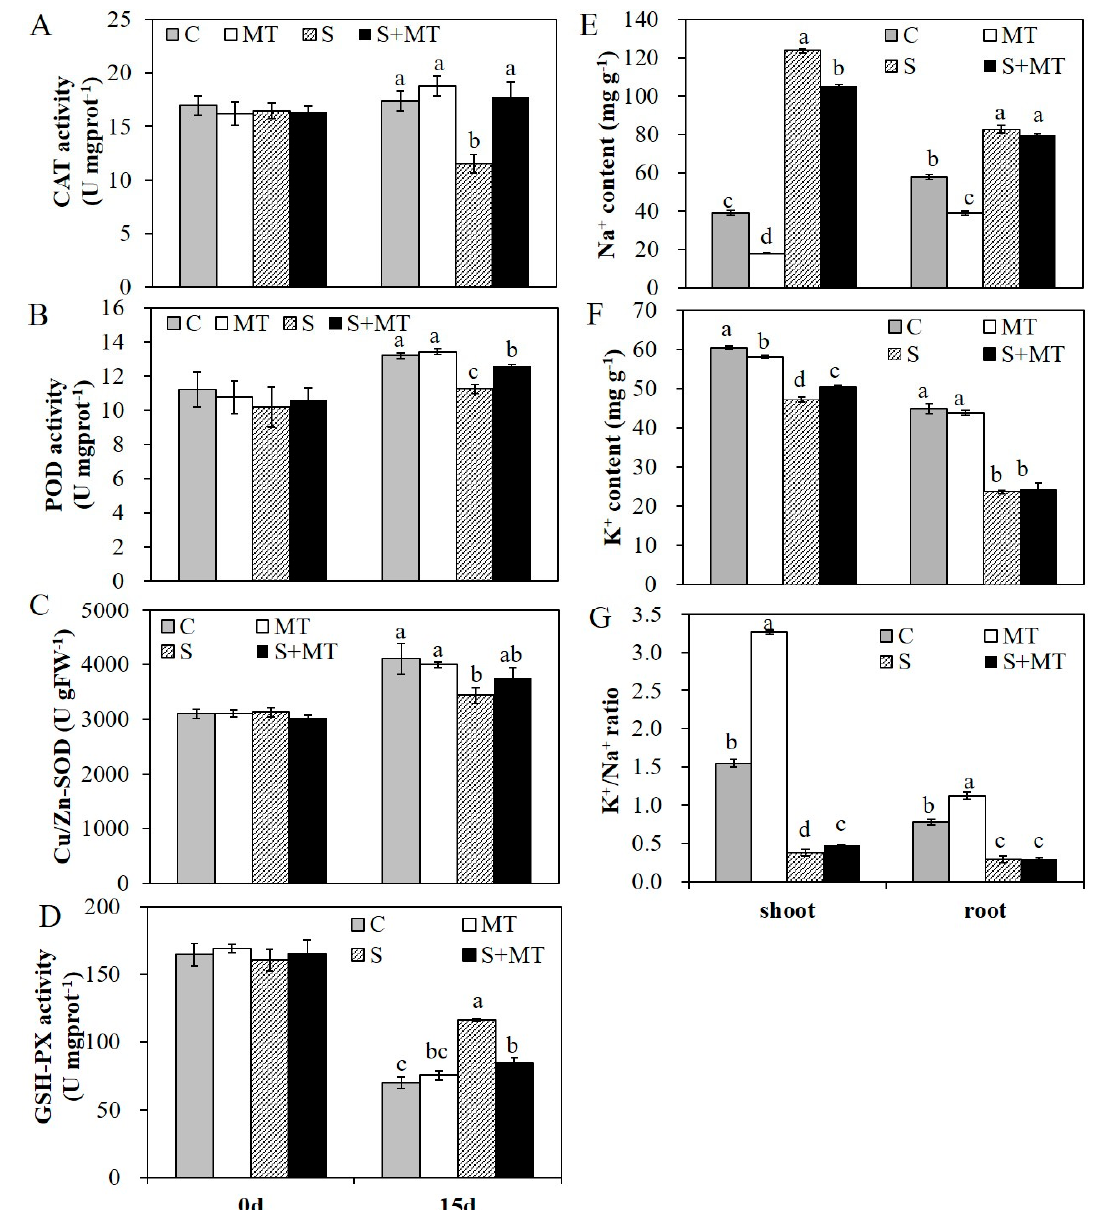
Figure 5. The activities of antioxidative enzymes and the Na + , K + contents of alfalfa plants under normal or salt stress (200 mM NaCl) conditions. A–D, the activities of CAT ( A ), POD ( B ), Cu / Zn-SOD ( C ) and glutathione peroxidase (GSH-PX) ( D ) in di ff erent groups of plants before and after salt stress treatment; E–G, Na + content ( E ), K + content ( F ), and the K + / Na + ratio ( G ) in the shoots and roots of one-month-old alfalfa plants pretreated with MT and exposed to salt stress with 200 mM NaCl for 15 days. Data are represented as means ± SE ( n = 3), and bars with di ff erent letters indicate the di ff erences between these four di ff erent groups according to ANOVA analysis ( p < 0.05).